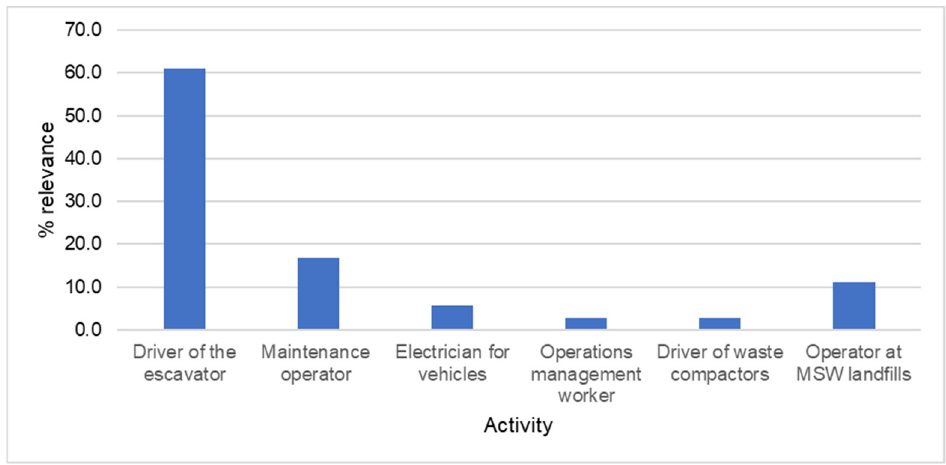
Figure 5. Relevance of work activities in landfill accidents (in percentage).